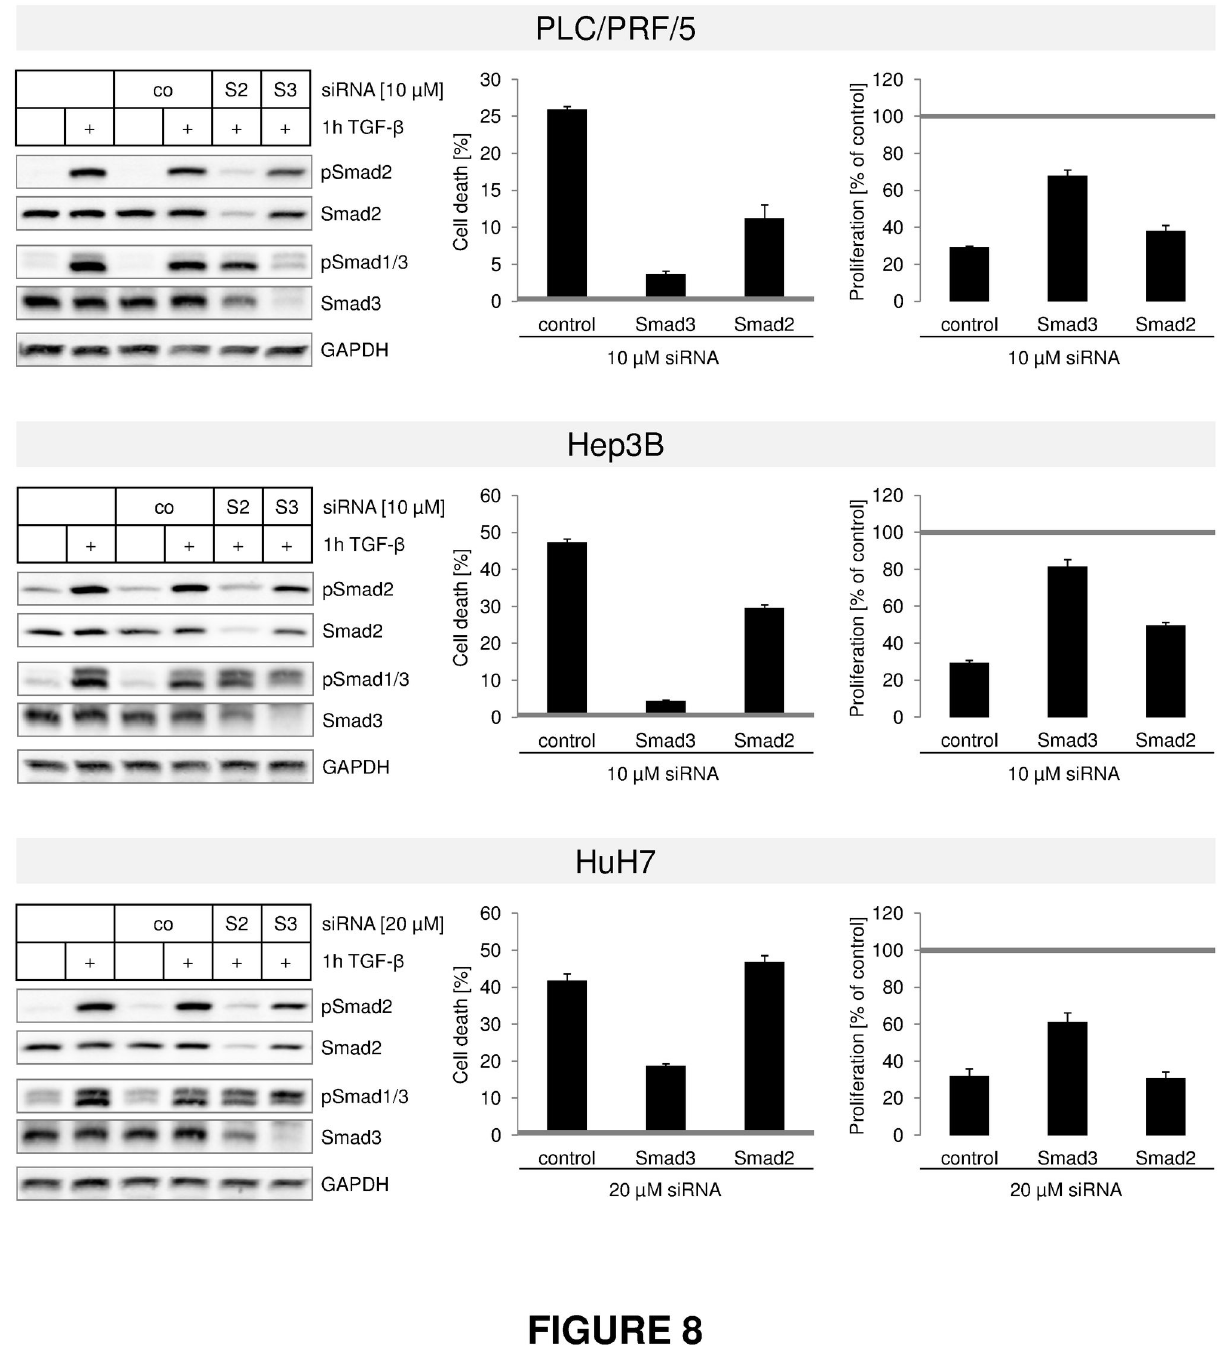
Figure 8. TGF-β induced cell death is Smad3 dependent. RNA interference technology was used to downregulate Smad2 (S2) and Smad3 (S3) in PLC/PRF/5 (upper panel), Hep3B (middle panel) and HuH7 (lower panel) cells. An unspecific siRNA sequence (co) was used as control. Knockdown was allowed to take place for 48 h. Afterwards, each setup was treated with or without 5 ng/ml TGF-β for 1 (Immunoblot) or 3 days (cell death and proliferation) (Left). Western blot analysis against phosphorylated and total Smad2 and Smad1/3 was performed to confirm successful knockdown. GAPDH was used as loading control (Middle). After 3 days with or without TGF-β, cell death rates were evaluated using an LDH assay. Untreated cells for each siRNA were defined as 0 (grey line). Filled bars show TGF-β treated samples (Right). LDH content of viable (adherent) cells was used to determine proliferation rates. TGF-β treated samples (filled bars) were related to untreated siRNA samples (grey line). doi: 10.1371/journal.pone.0072252.g008 PLOS ONE |